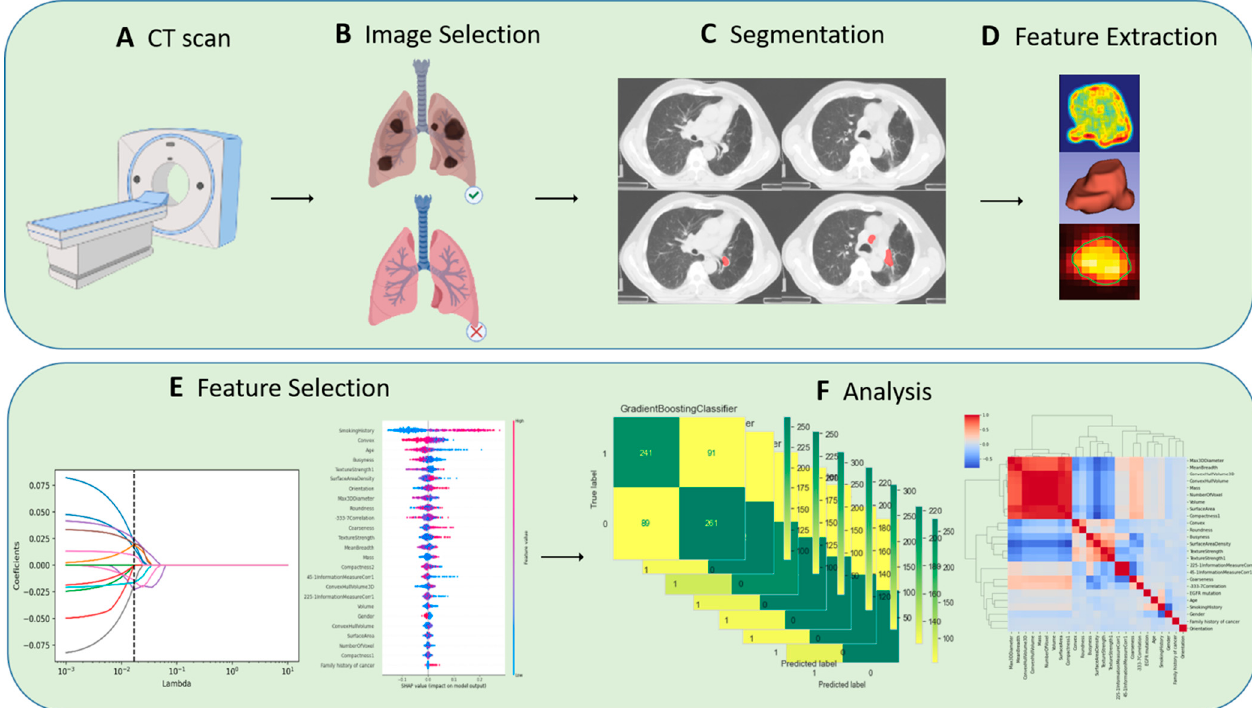
Figure 1. Overview of radiomics workflow.